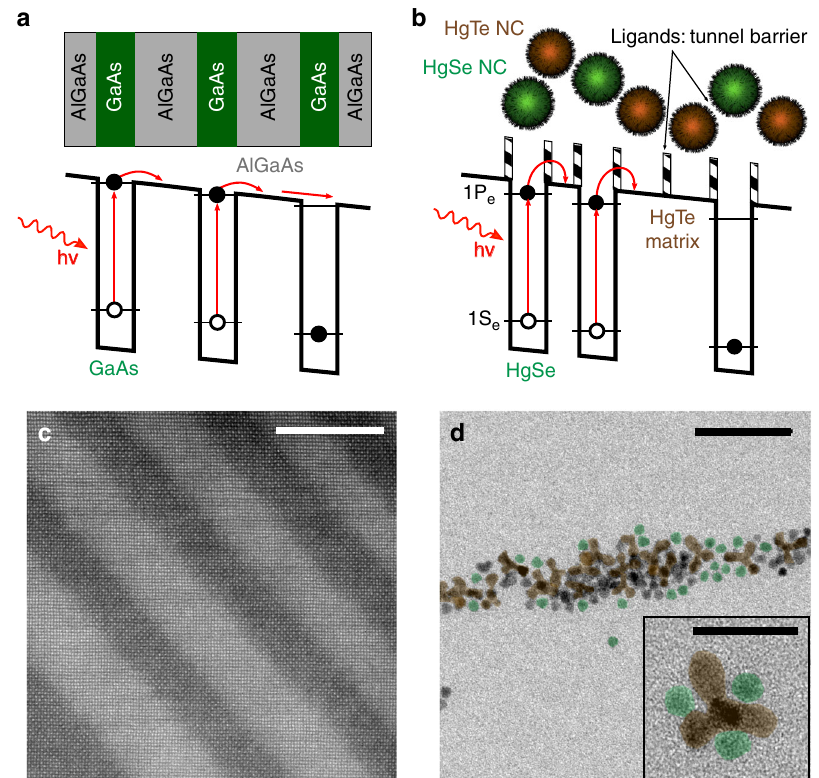
Fig. 1 Principle of operation for a random colloidal quantum dot infrared photodetector (CQDIP). a Scheme of a standard GaAs/AlGaAs quantum well infrared photodetector (QWIP) band structure under polarization. b Scheme of polarized band structure of a random CQDIP consisting of HgSe nanocrystals (NCs) as absorber material and HgTe NCs as barrier material. c Transmission electron microscopic (TEM) image of an epitaxially grown GaAs/AlGaAs QWIP structure. GaAs quantum wells are shown in dark. Scale bar is 20 nm. d TEM image of mixed HgSe and HgTe NCs for random CQDIP fabrication. Some HgSe (resp. HgTe) NCs have been colored in green (resp. brown). Scale bar is 50 nm. Inset: higher-resolution TEM image showing a HgTe tetrapod along with three HgSe spheres. Scale bar is 20